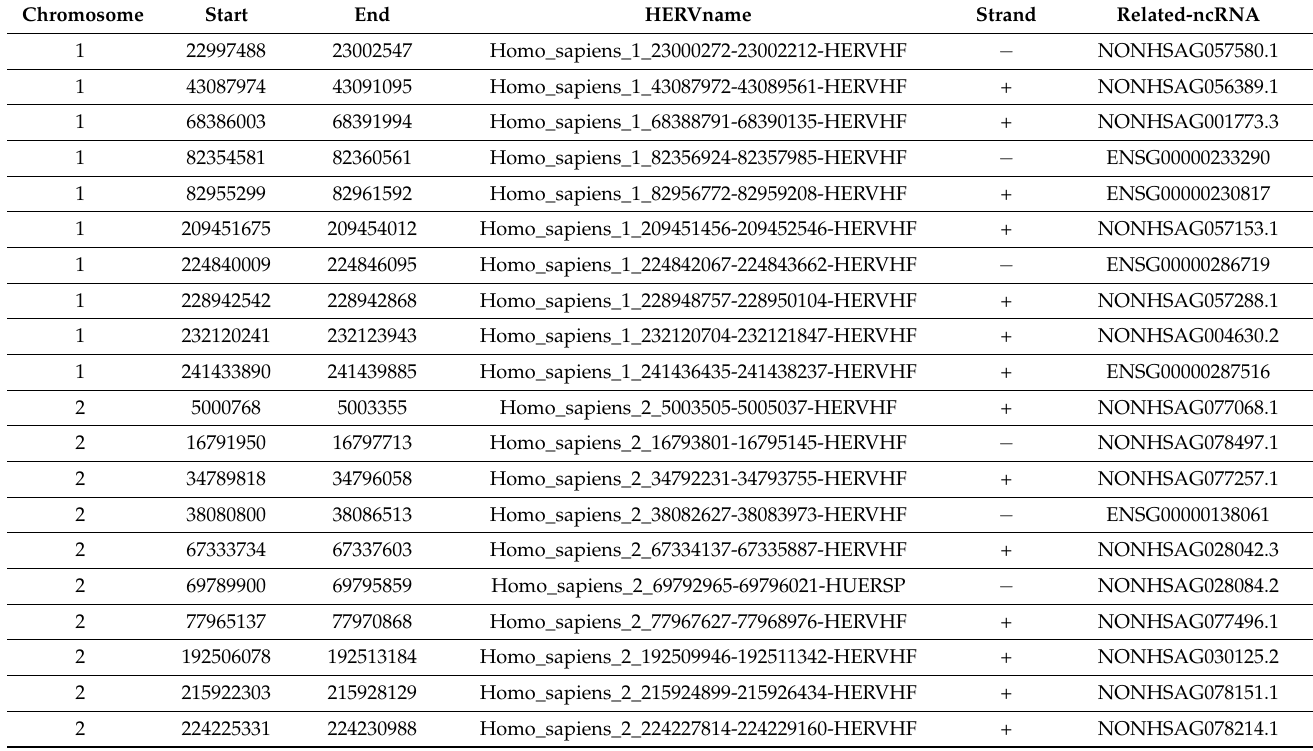
Table 1. The annotation of HERV related ncRNAs in